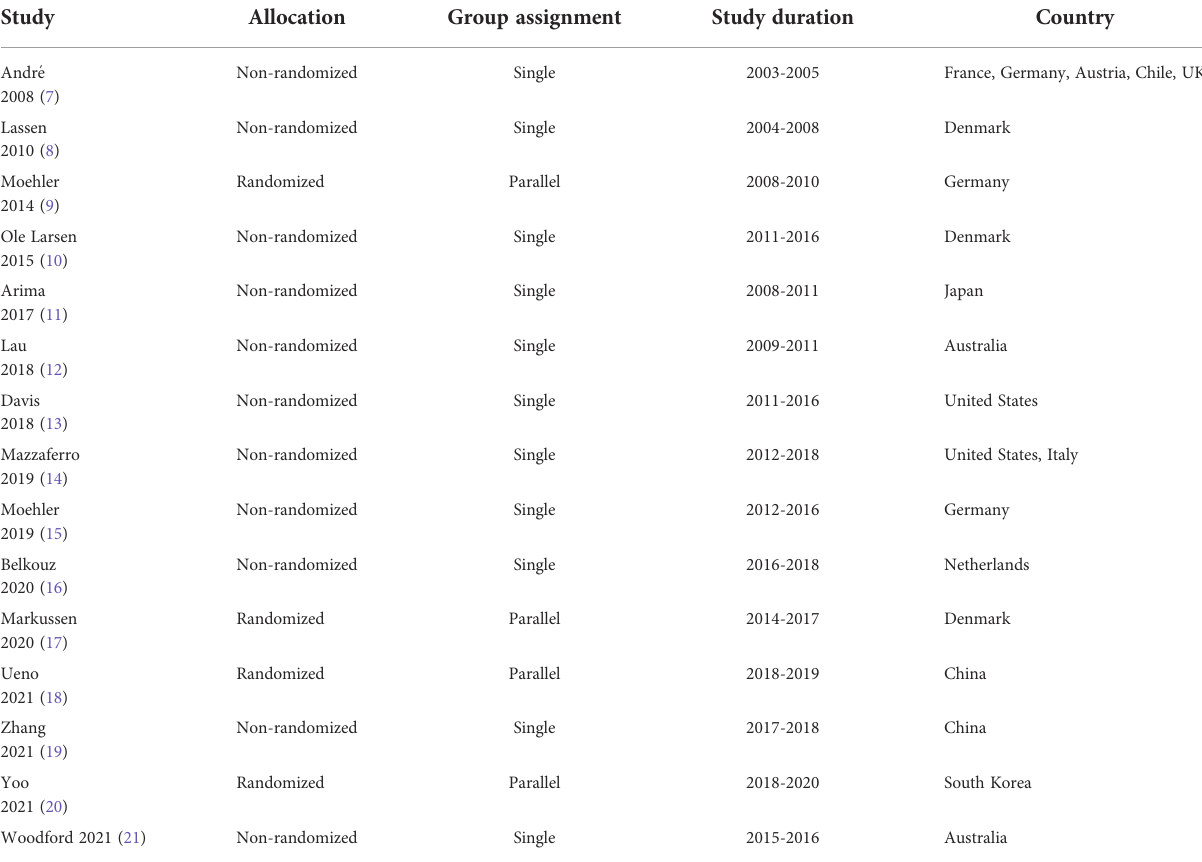
TABLE 1 Characteristics of studies included in the